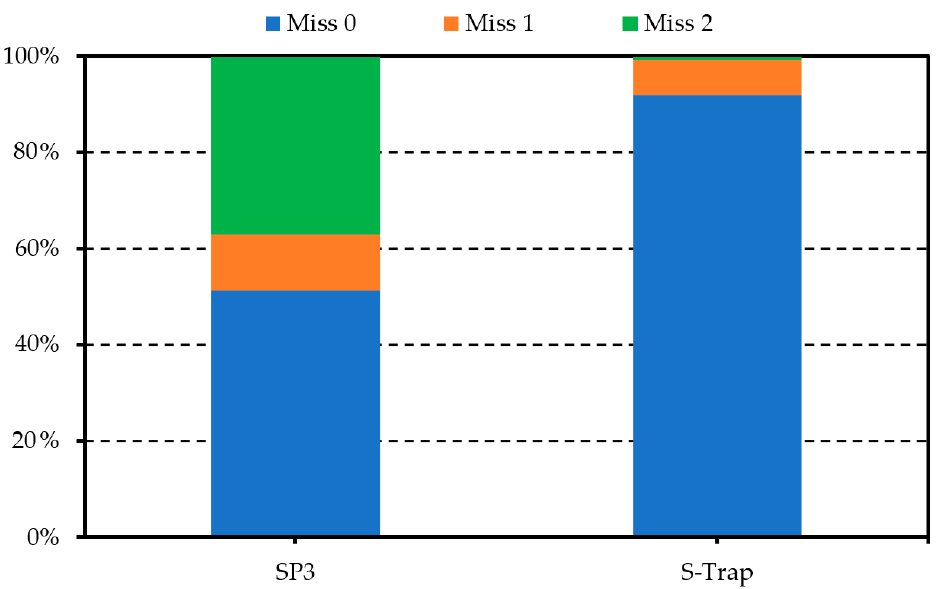
Figure 3. The percentage of proteins with no missing values (Miss 0), one missing value (Miss 1), and two missing values (Miss 2).